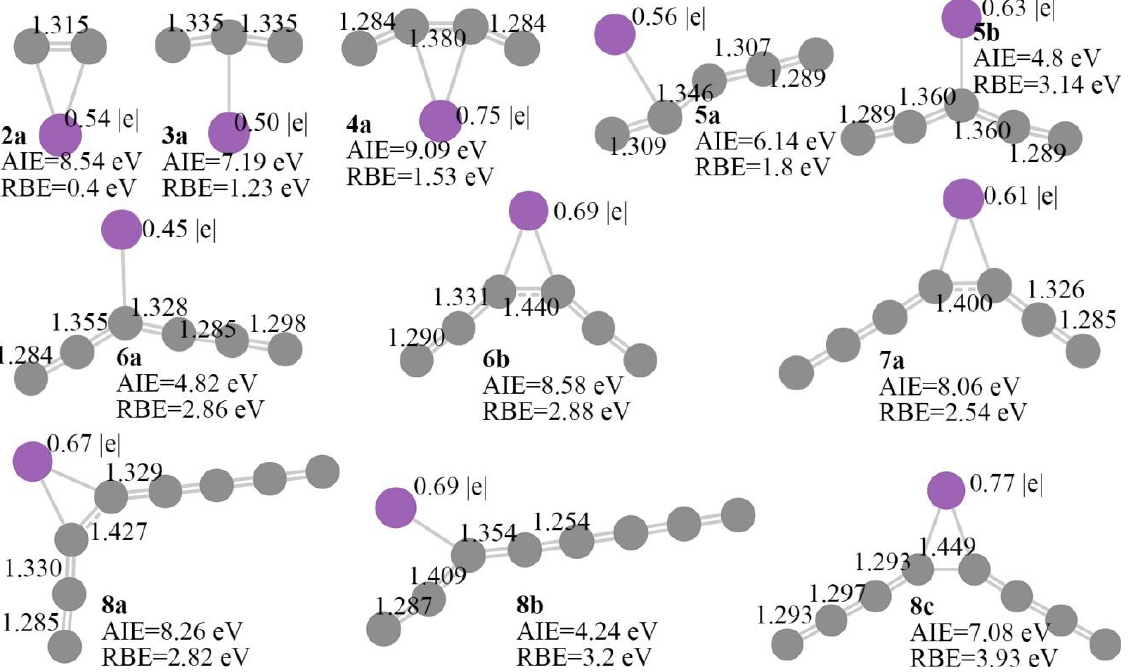
Figure 19. Structural geometry, adiabatic ionization energy (AIE), relative binding energy (RBE), and charge population influenced by binding site of antimony atom. Relative binding energy is calculated by equation: RBE = E b ( nt ) − E b ( t ) , where E b ( nt ) and E b ( t ) stand for structure with antimony binding on nonterminal carbon and linear structure with antimony binding on terminal carbon, respectively. Notations na, nb, and nc represent the structures with n carbon